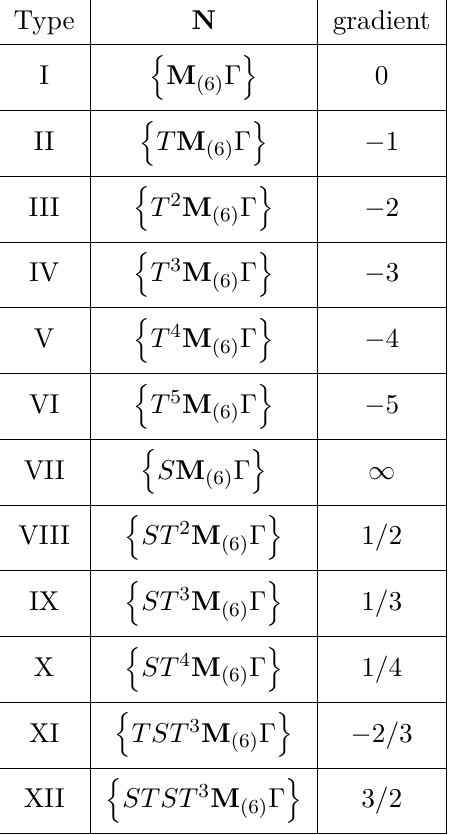
Table 14 . Types for D = 6 .